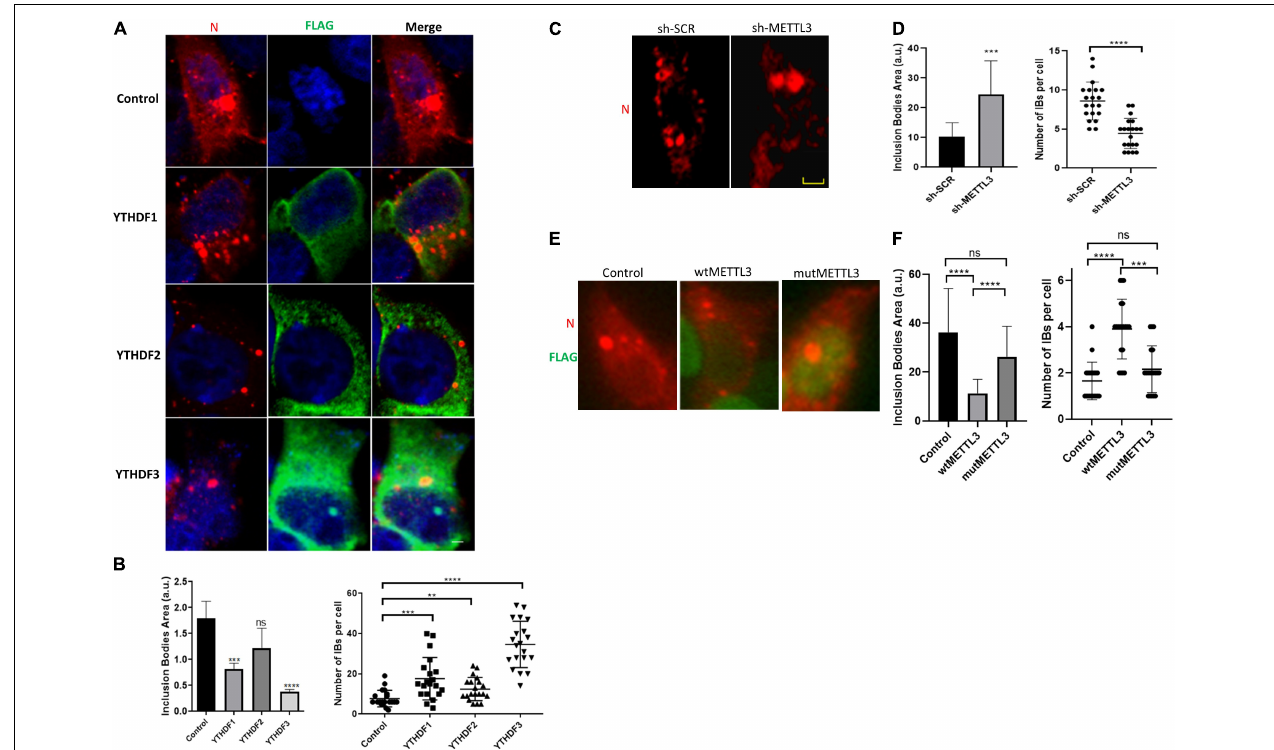
FIGURE 4 | YTHDF proteins decrease in size but increase the number of inclusion bodies during HRSV infection. (A) Fluorescent photomicrographs of HEK293T cells transfected with vector expressing YTHDF proteins and infected with HRSV at MOI:1 for 24 h. Antibody anti-Flag (green) was used for immunostained YTHDF proteins and HRSV N (red). Nuclei (blue) was labeled with DAPI. (B) The area and number of IBs were quantified using Image J. (C) The localization of N protein (red) was analyzed by indirect immunofluorescence in HEK293T in which METTL3 was knocked down and shRNA control infected with HRSV at MOI:1 for 24 h. (D) The area and number of IBs were quantified using Image J. (E) The localization of N protein (red) and Flag (green) of HEK293T transfected with vector expressing wild-type or D395A METTL3 was analyzed by immunofluorescence. (F) The area and number of IBs were quantified using Image J. Data represent the mean ± SD ( n = 20 cells per condition). Scale bar: 20 µ m. The statistical significance was calculated, where: ** p < 0.01; *** p < 0.001; **** p < 0.0001; ns, not